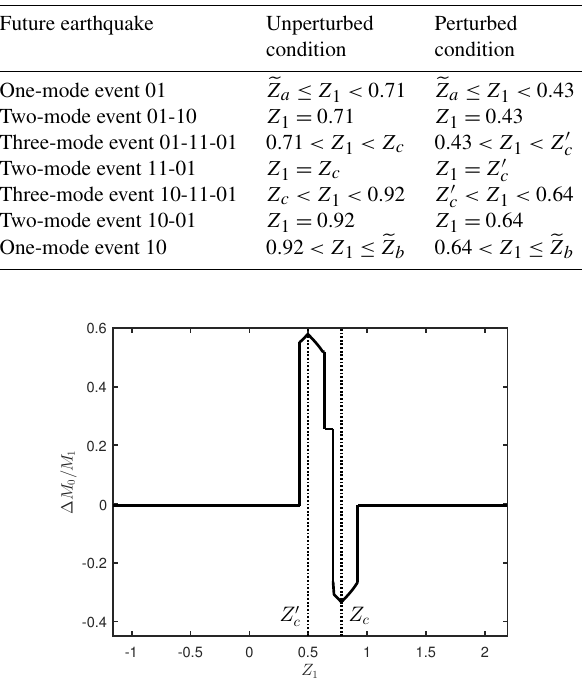
Figure 7. Change in the seismic moment released during the next event on the 1992 Landers, California, fault, as a result of the stress perturbation due to the 1999 Hector Mine, California, earthquake. On the horizontal axis, the variable Z 1 describing the initial state of the 1992 event. The kinds of seismic event predicted by the model, corresponding to different intervals of Z 1 , are listed in Table 3. The values Z 1 = Z c and Z 1 = Z (cid:48) c correspond to the largest possible earthquakes before and after the stress perturbation, respectively.